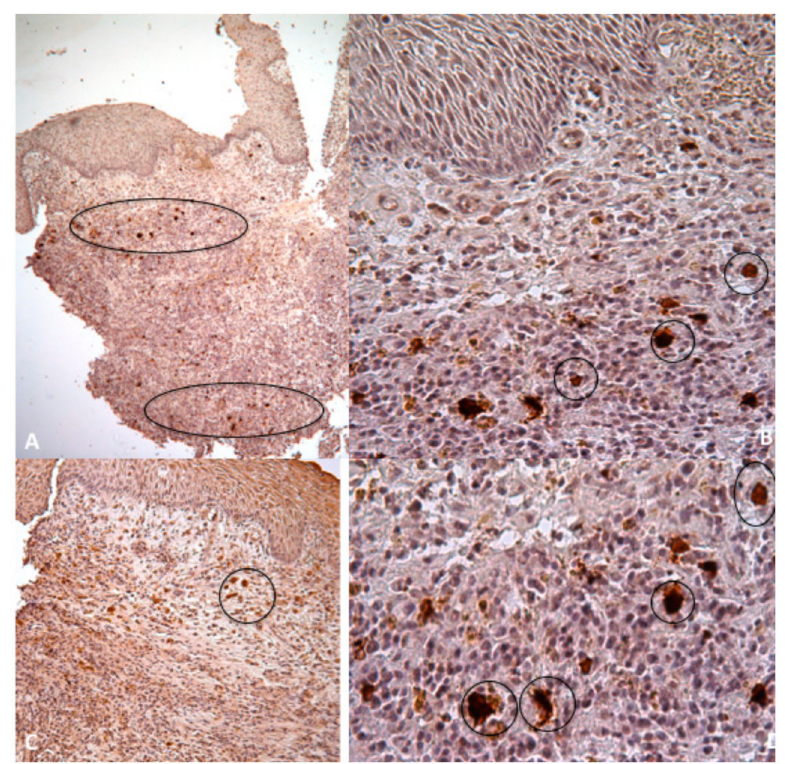
Figure 11. Immunohistochemistry against CD31 for endothelial cells show that the apical zone contains larger amounts of small vascular structures than the corresponding lower situation (black circles, A,C 5 × ; B,D 20 × ).